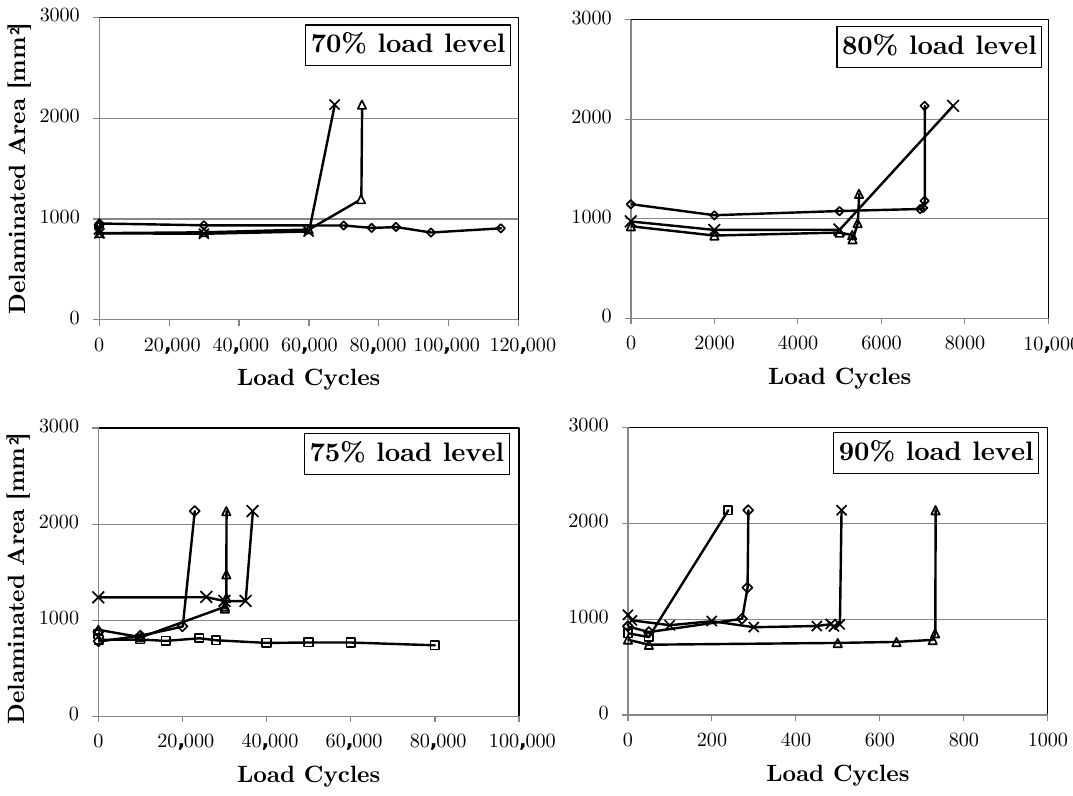
Figure 9. Delamination history of the specimens per load level obtained from the ultrasonic scanning between the load interval. The last data point of each curve represents the final